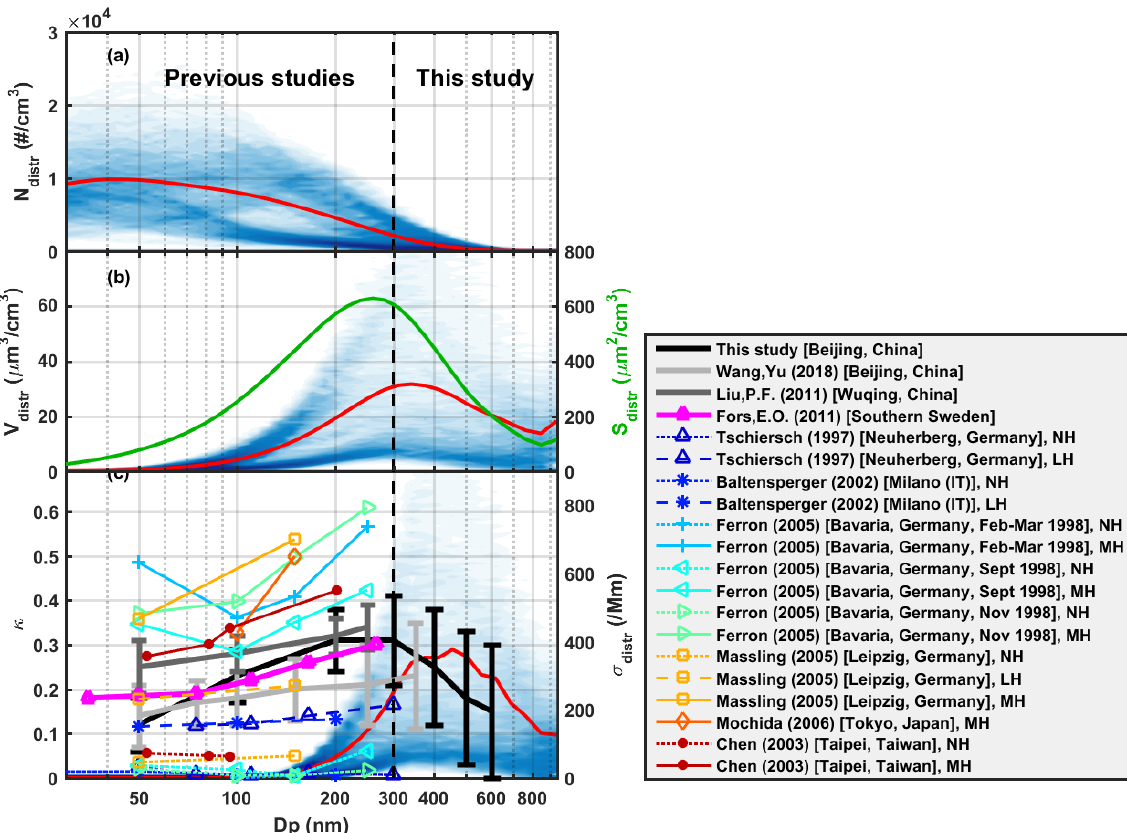
Figure 1. Frequency distribution of (a) aerosol number size distribution during the whole measurement period, (b) corresponding volume size distribution, and (c) size-resolved light extinction coefficient contribution calculated from Mie theory. The red lines in (a) – (c) represent the mean values. The lines with marks in (c) denote the hygroscopicity measurement by HTDMA in previous studies and our